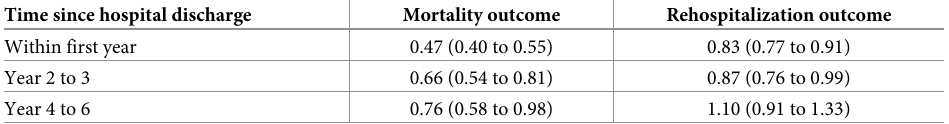
Table 3. Period-specific aHRs for associations between OAT and all-cause mortality or rehospitalization for injecting-related